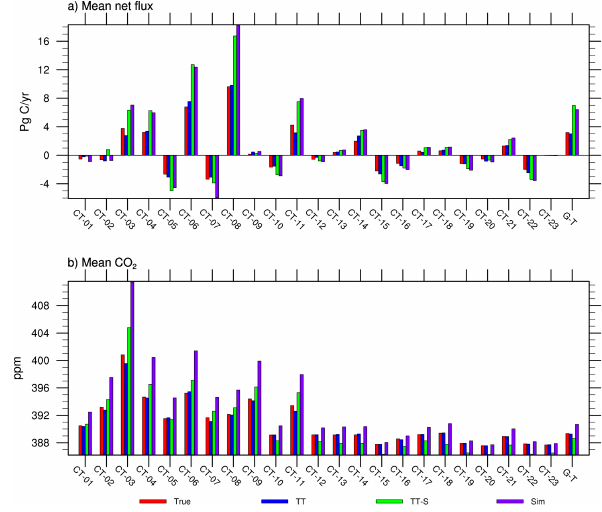
Figure 7. (a) Mean CO 2 surface fluxes and (b) CO 2 concentra- tion from the “truth”, simulations, TT-S (the simplified version of Tan-Tracker) and TT (Tan-Tracker) assimilations aggregated to TransCom regions (i.e., CT-01: North America Boreal; CT-02: North America Temperate; CT-03: South America Tropical; CT-04: South America Temperate; CT-05: Northern Africa; CT-06: South- ern Africa; CT-07: Eurasia Boreal; CT-08: Eurasia Temperate; CT- 09: Tropical Asia; CT-10: Australia; CT-11: Europe; CT-12: North Pacific Temperate; CT-13: West Pacific Tropical; CT-14: East Pa- cific Tropical; CT-15: South Pacific Temperate; CT-16: Northern Ocean; CT-17: North Atlantic Temperate; CT-18: Atlantic Tropics; CT-19: South Atlantic Temperate; CT-20: Southern Ocean; CT-21: India Tropical; CT-22: South India Tropical; CT-23: Zero Flux Re- gions; G-T: Global Total) during the period from 1 June to 31 De- cember